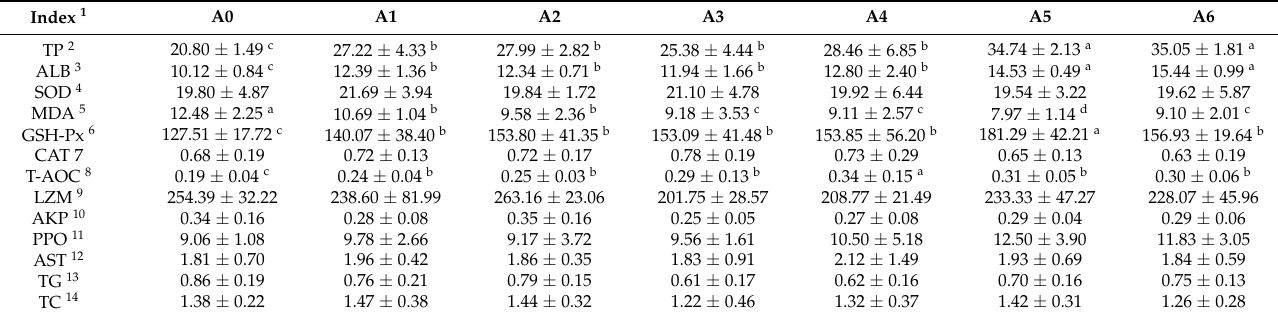
Table 4. Effects of Yarrowia lipolytica on main biochemical, immune and antioxidant indexes in serum of Litopenaeus vannamei